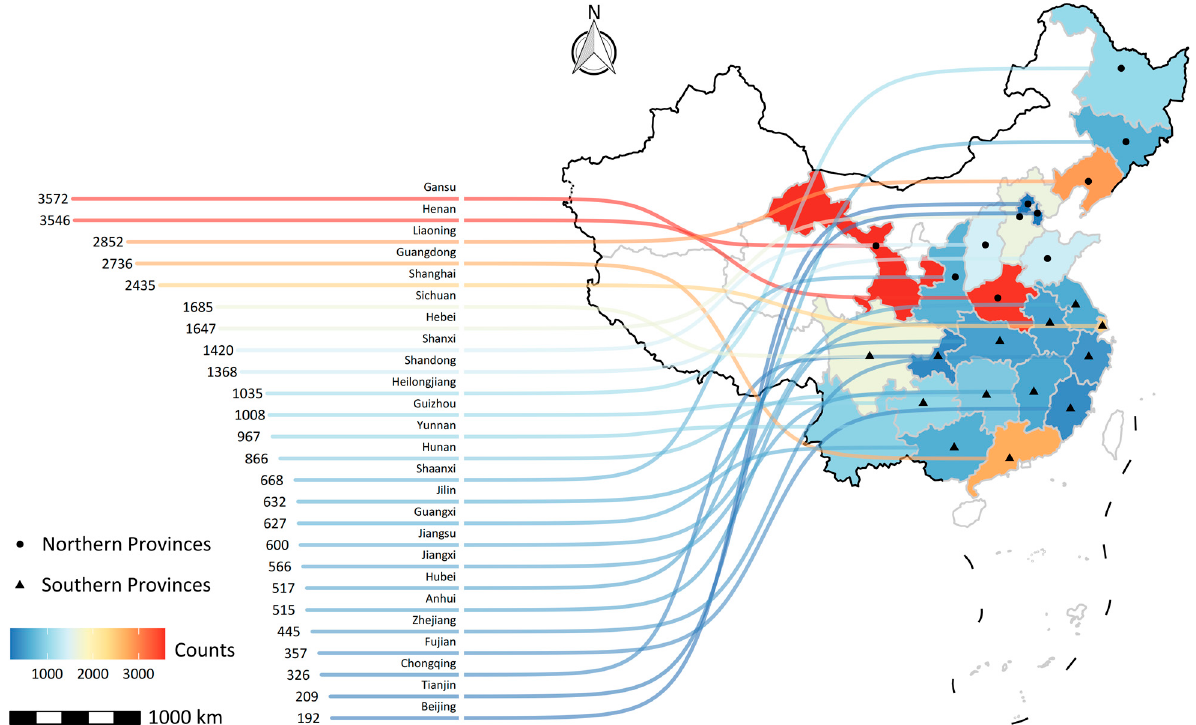
Figure 1. Provincial distribution of adult samples at baseline.